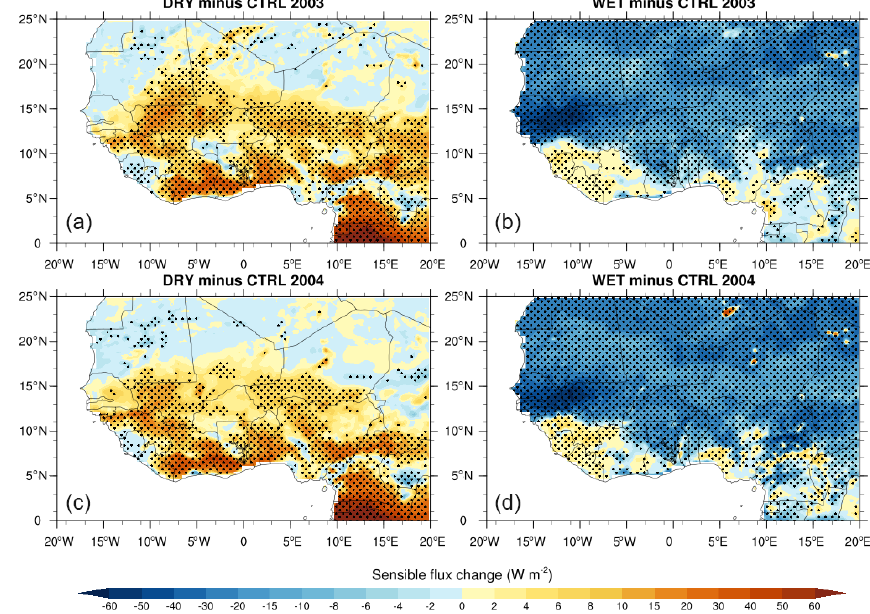
Figure 14. Same as Fig. 12 but for sensible heat fluxes (in Wm − 2 ).